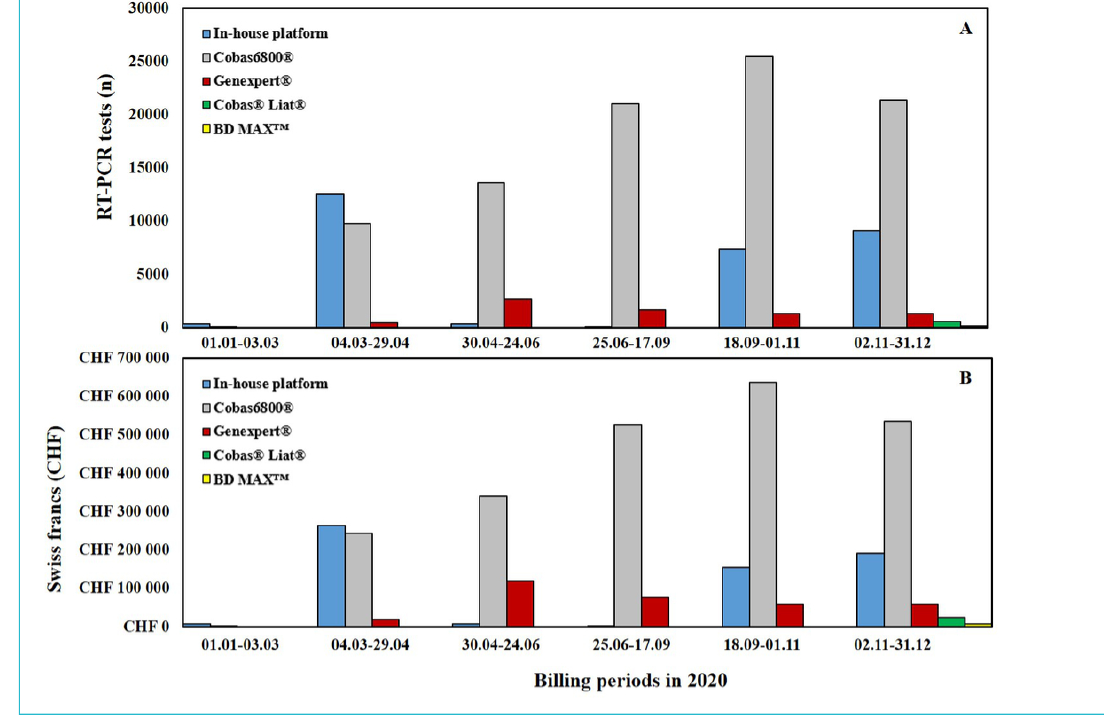
Figure 3: Variations in the number of RT-PCR tests performed and the cumulative costs per molecular platform per billing period throughout 2020 at Lausanne University Hospital (Switzerland). A) Cumulative number of RT-PCR tests performed per molecular platform per billing peri-